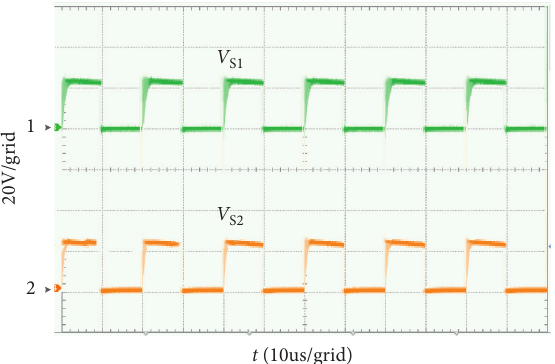
Figure 16: Waveform of V